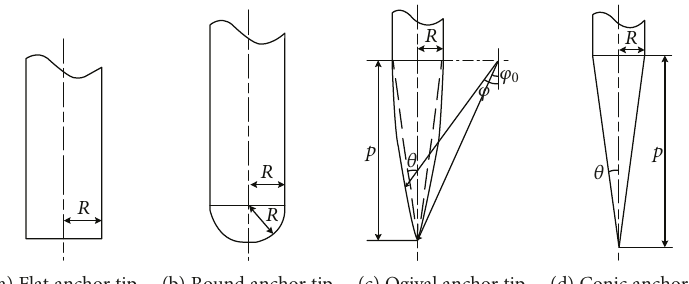
Figure 10: Schematic diagram of four typical anchor